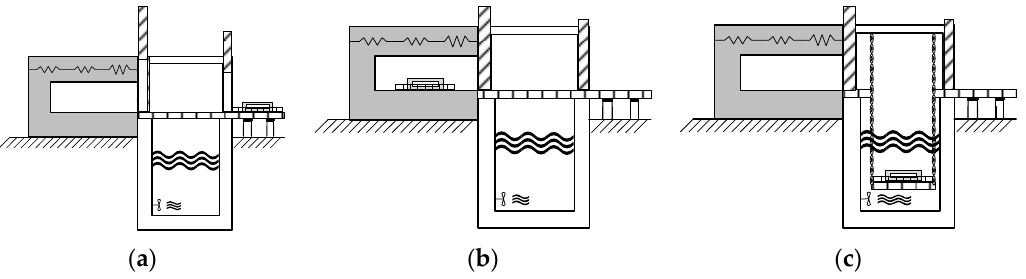
Figure 7. Schematic drawing of the furnace with the water cooling system: ( a ); Before workpiece loading ( b ) workpiece loading and heating; ( c ) water cooling.